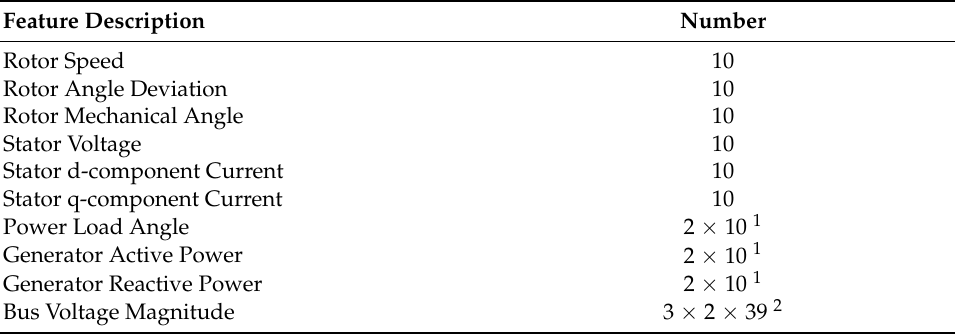
Table 1. Features derived from the time-domain